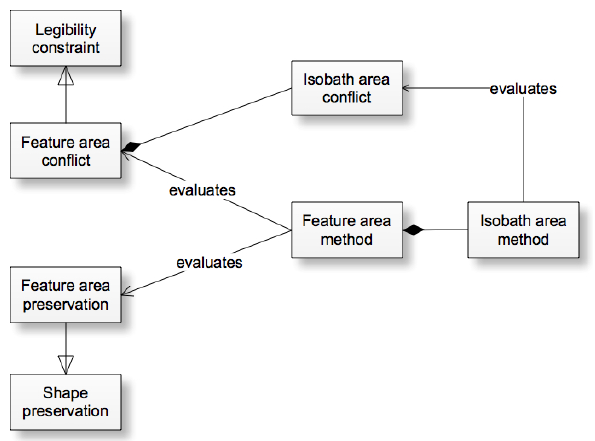
Figure 8: Example of relationships between constraints and eval-